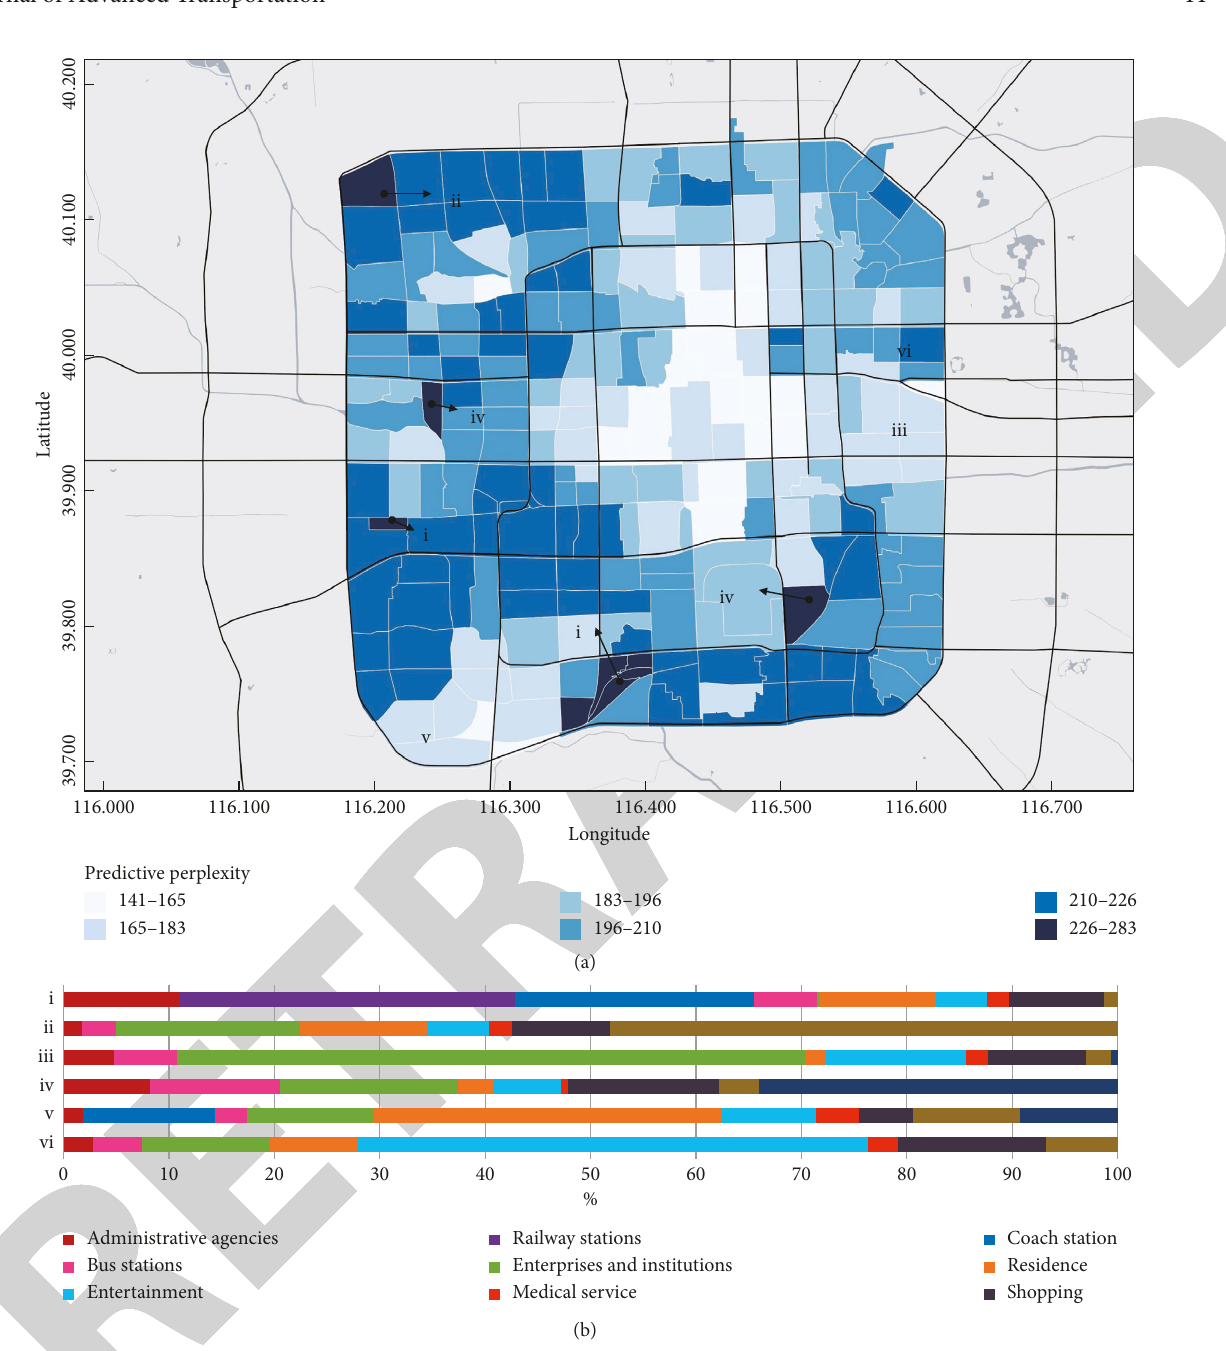
Figure 7: (a) Results of anomaly detection for the study areas and (b) POI statistics for areas i–vi showing the composition of each